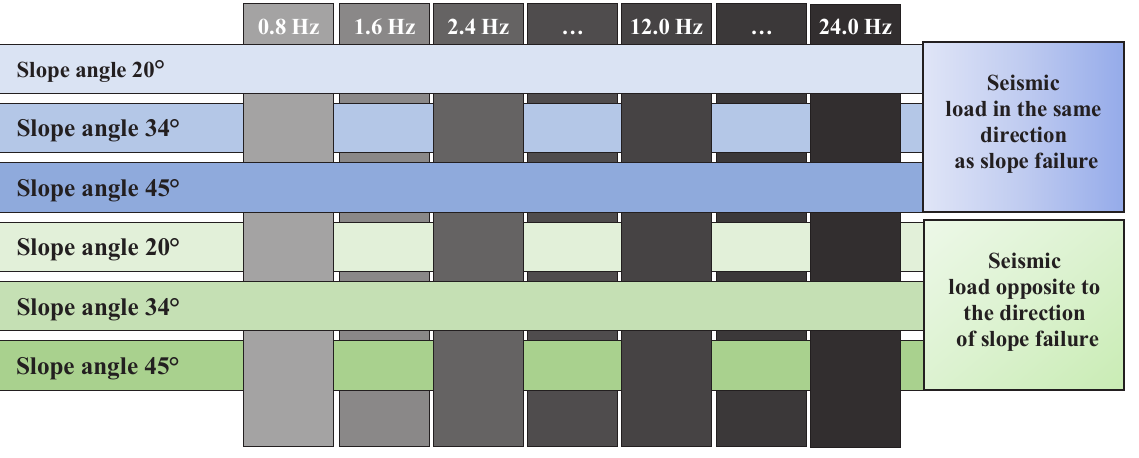
Figure 7: Matrix of numerical scenarios used for the presented research.